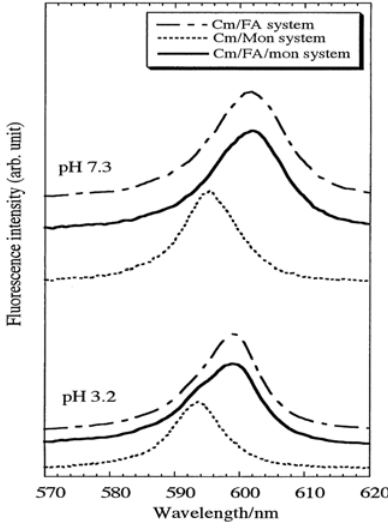
Figure 7. Fluorescence spectra of Cm(III) species in three systems: Cm(III)-fulvate (Cm/FA), Cm(III) species adsorbed on montmorillonite (Cm/mont), and Cm(III) species adsorbed on FA-montmorillonite hybrid (Cm/FA/mont). Total concentrations of Cm(III), fulvic acid, and montmorillonite are 2.0 × 10 -6 mol/L, 100 mg/L, and 4.0 g/L, respectively